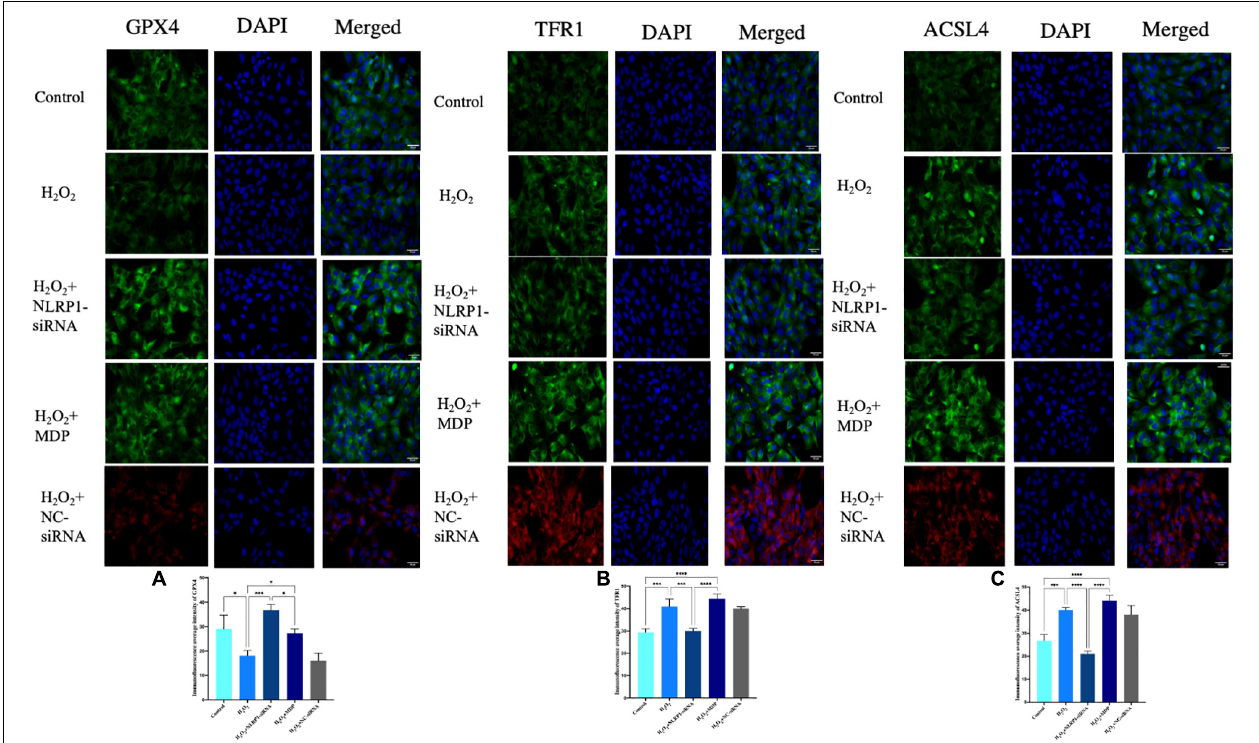
FIGURE 3 | Ferroptosis-related protein expression in HTR-8/SVneo cells, as determined by immunofluorescence. Rabbit anti-GPX4 monoclonal antibody (green) and DAPI staining were used to visualize nuclear (blue) immunolabeling. Scale: 50 µ m. Nuclear DAPI staining (blue) with rabbit anti-TFR1 monoclonal antibody (green) immunostaining, as shown by fluorescence microscopy. Scale: 50 µ m. Nuclear DAPI staining (blue) with rabbit anti-ACSL4 monoclonal antibody (green) immunostaining, as shown by fluorescence microscopy. Scale: 50 µ m. siRNA-NC (red) and DAPI staining were used to visualize nuclear (blue) immunolabeling. Scale: 50 µ m. Mean immunofluorescence intensity of ferroptosis-associated proteins: (A) GPX4, (B) TFR1, and (C) ACSL4 (* P < 0.05, ** P < 0.01, *** P < 0.001, and **** P < 0.0001). Values represent means ± SD, n = 3 per